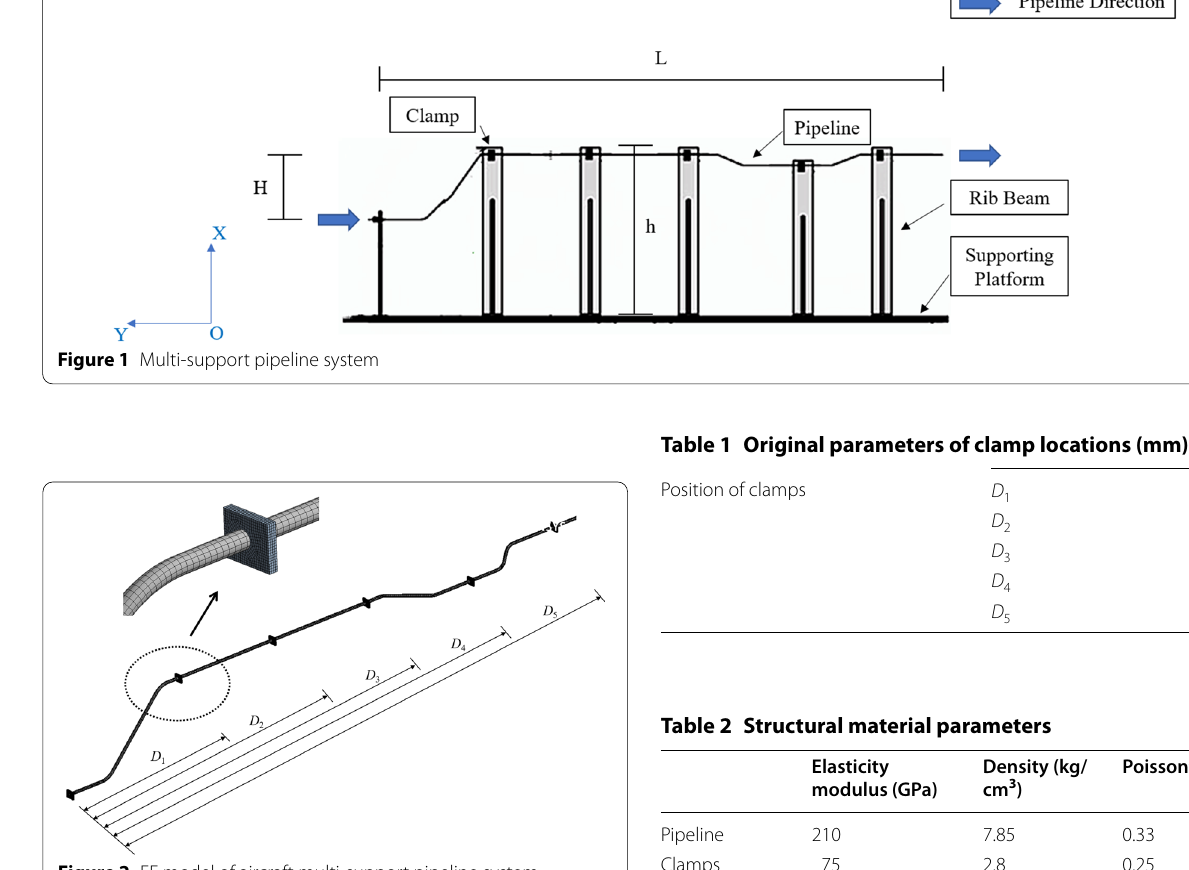
Figure 2 FE model of aircraft multi-support pipeline system